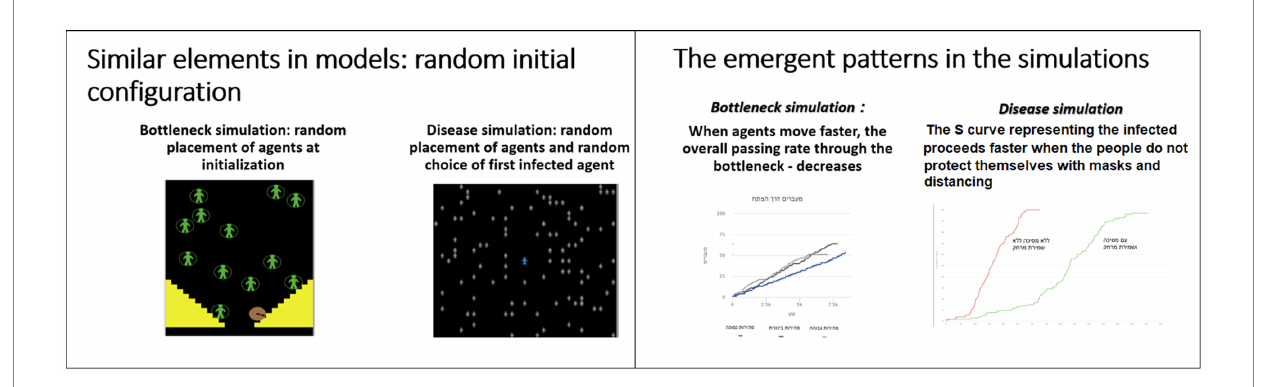
FIGURE 6 Slides presented after interacting with both the disease and the bottleneck simulations. The left slide mentions the random setup of both systems and right slide presents how parameters influence the emergent pattern in each simulation, as represented by the graphs of the overall passers through the bottleneck and the overall infected